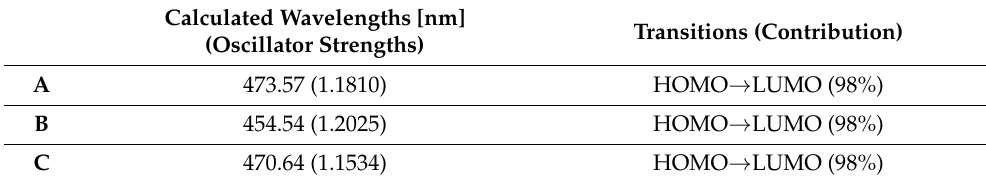
Table 6. The calculated by TD-DFT (6-31G(d,p)/CAM-B3LYP) wavelengths of emission with oscillator strengths for A – C